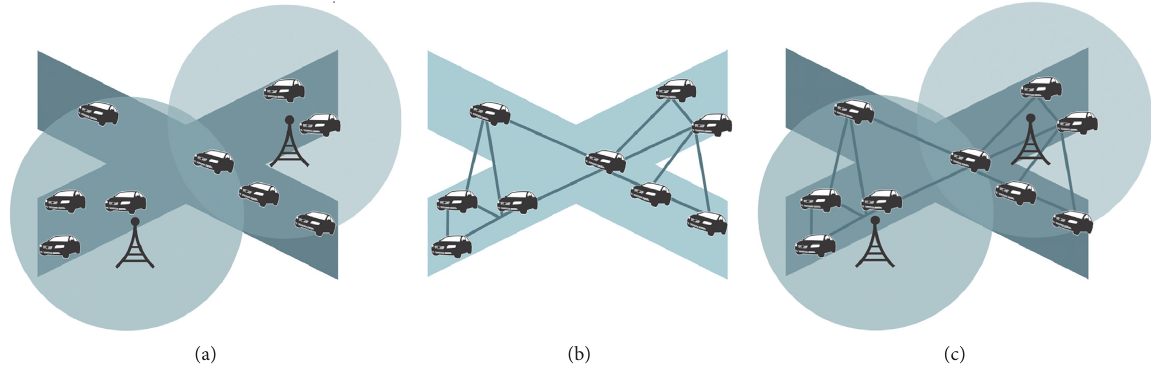
Figure 1: Network architectures for VANETs. (a) Infra-structured. (b) Ad hoc. (c) Hybrid.